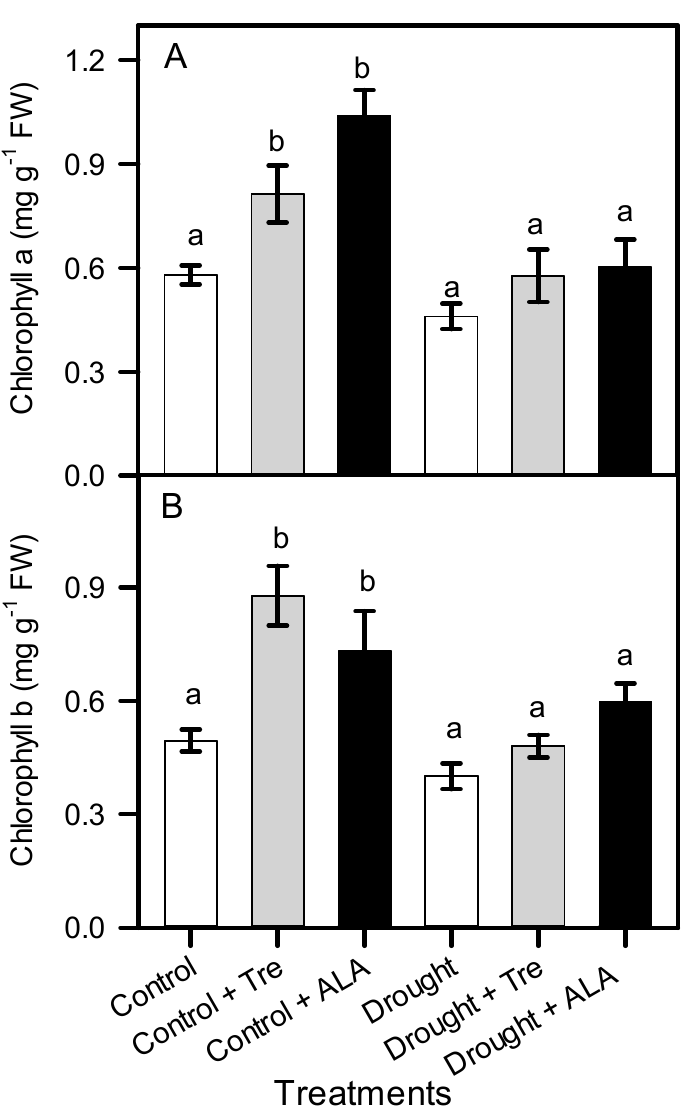
Figure 4. Chlorophyll a ( A ) and chlorophyll b ( B ) concentrations in leaves of well-watered (100% FC, Control) and drought-stressed (65% FC, Drought) Alpinia zerumbet treated with foliar applications of water alone, 25 mM trehalose (Tre) or 10 mg L − 1 5-aminolevulinic acid (ALA). Values are means ± S.E. ( n = 6). Different letters above the bars indicate significant differences based on LSD analysis at p < 0.05.